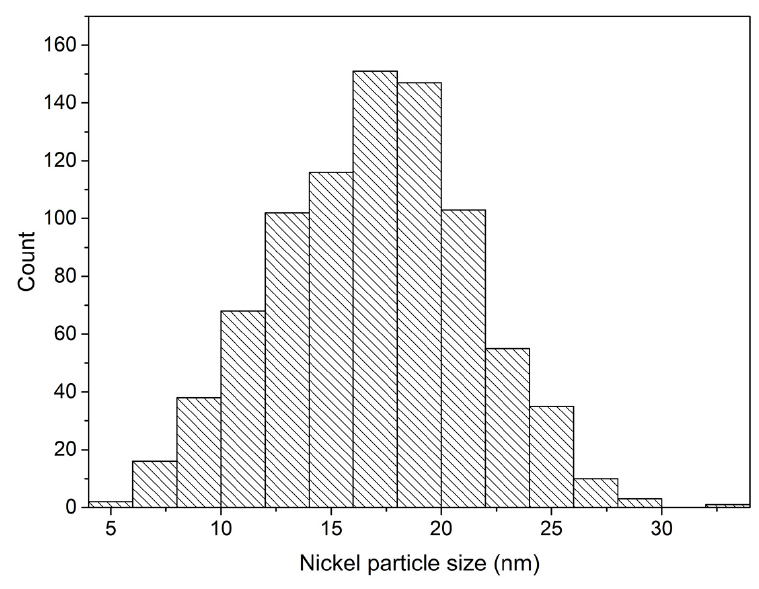
Figure 5. Distribution of nickel particle sizes on the surface of hydrolysis lignin after calcination in a CO 2 atmosphere according to the TEM data.